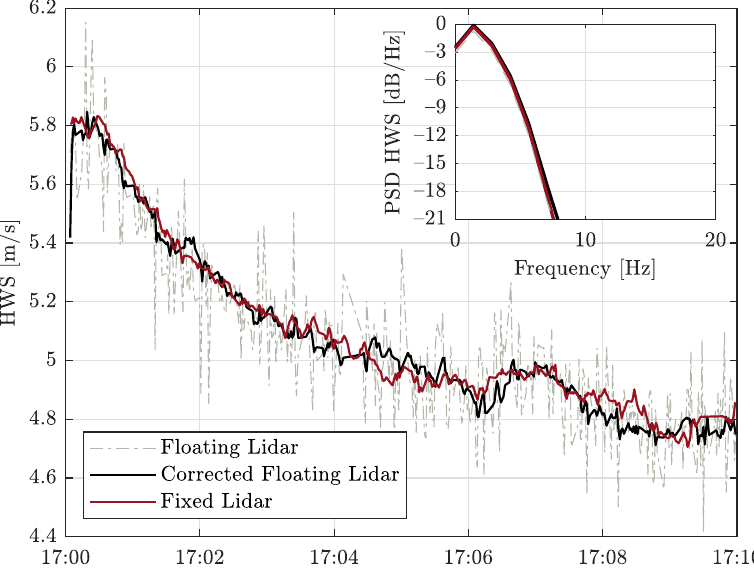
Figure 8. HWS time-series measured at 100 m height between the fixed LiDAR and the FDWL, with and without correction (see legend). Inset: PSD comparison. Low HWS-variance scenario (7 June 2013,